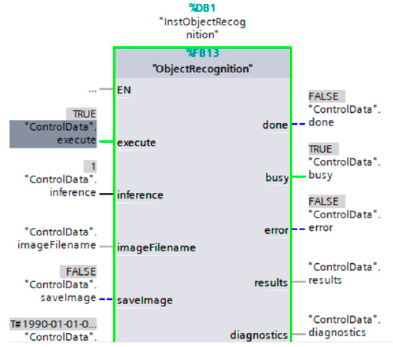
Figure 9. Part of the program written in TIA Portal to read data from the camera and run the interference parameter (“ControlData” interference), which in this case concerns image classification (according to the learned AI model). The green color is evidence of the operation of the controller in the given calculation process.